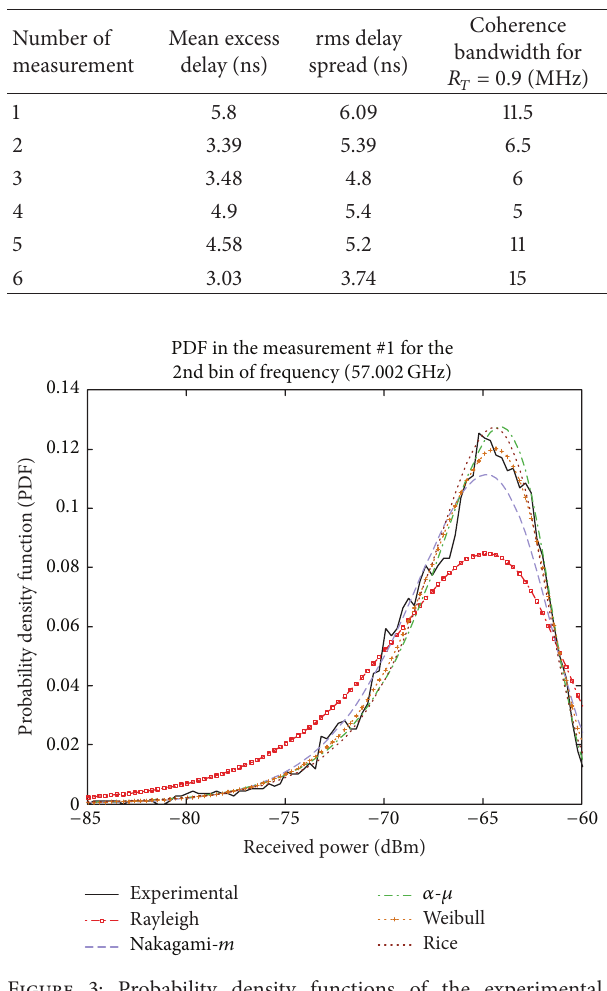
Figure 3: Probability density functions of the experimental, Rayleigh, Nakagami- m , 𝛼 - 𝜇 , Weibull and, Rice distributions for the 2nd bin (frequency of 57.002 GHz) of the measurement